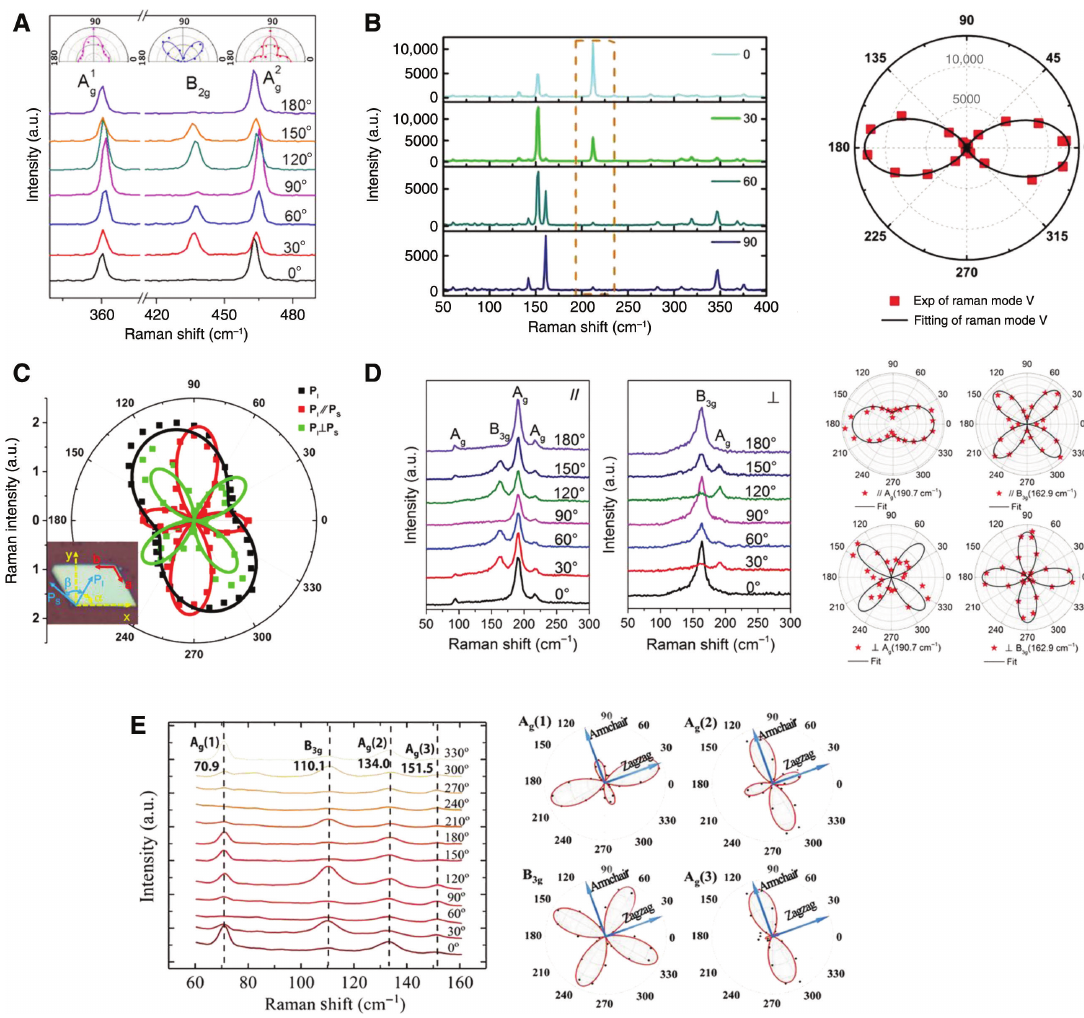
Figure 2: The angle-resolved polarized Raman spectroscopy of the anisotropic 2DLMs. (A) BP flake (the insert shows the corresponding polar plots). Reproduced with permission from Ref. Ling et al. [93]. (B) ReS resolved polarized Raman spectroscopy with V-mode highlighted in orange and corresponding polar plot of the Raman intensity of V-mode. Reproduced with permission from Meng et al. [94]. (C) ReSe : polar plots of the extracted angular-dependent intensity at Raman peak 2 238 cm −1 under “only incident,” “parallel,” and “perpendicular” configurations. Reproduced with permission from Zhang et al. [102]. (D) SnS: Raman spectra of 14.6-nm SnS flake with 532-nm incident laser under parallel and perpendicular polarization configurations (left figure); the polar plots of intensity of A and B under parallel and perpendicular polarization (right figure), respectively. Reproduced with g 3g permission from Xia et al. [120]. (E) SnSe: the angle-resolved polarized Raman spectroscopy (left figure); angular dependence of the Raman intensities of A (1), B , A (2), and A (3) modes (right figure). Reproduced with permission from Zhang et al. g 3g g g